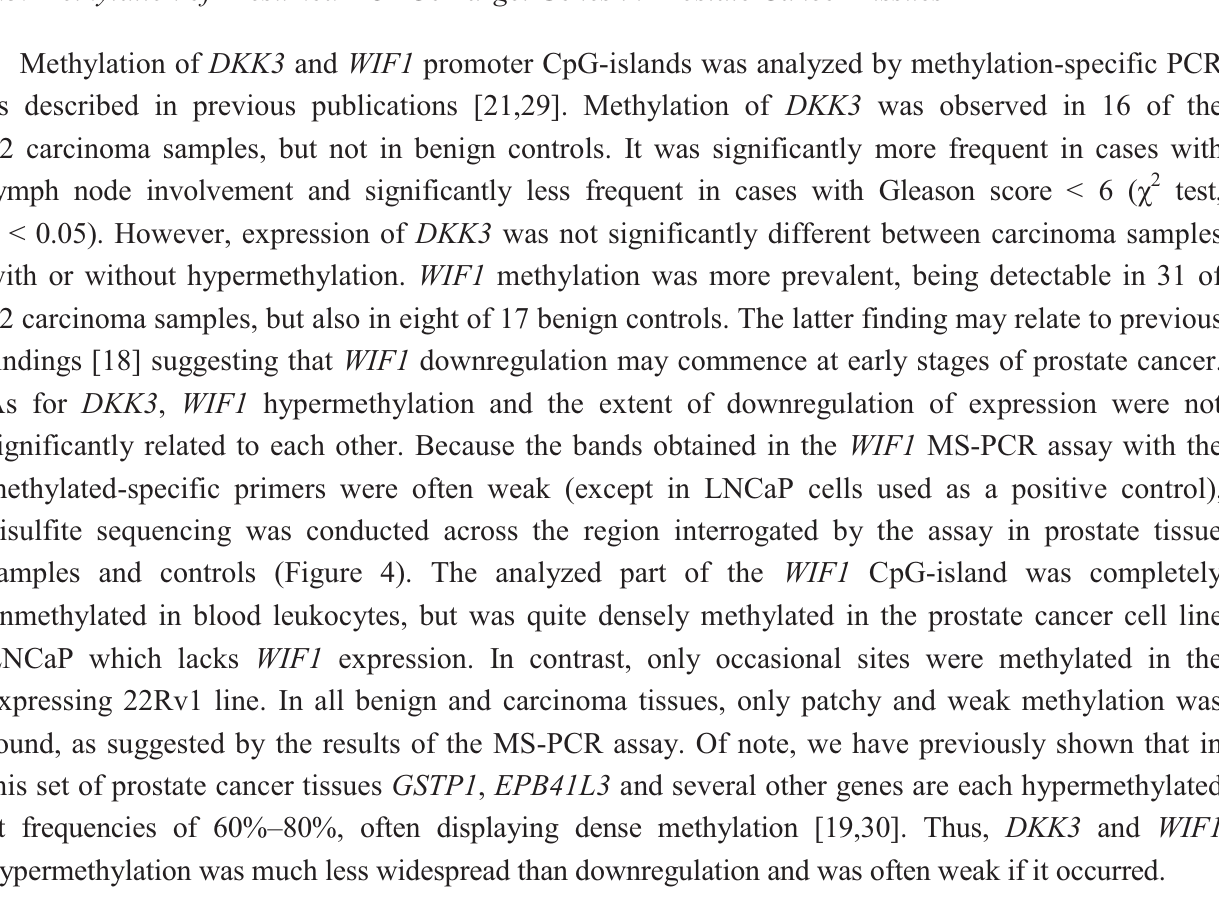
Figure 4. WIF1 methylation in prostate cancer. Bisulfite sequencing analysis of WIF1 promoter methylation in blood leukocytes, prostate cancer cell lines with high (22Rv1) and low (LNCaP) expression, benign and carcinoma prostate tissues. Each line represents one cloned PCR product, each circle represents one CpG site. Dark circles indicate methylated and light circles unmethylated sites. Some sites at the 3'-end of the sequence were difficult to read and are labeled by